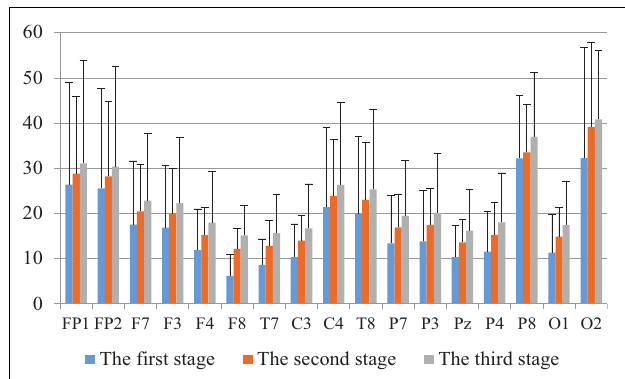
FIGURE 8 | The characteristics of theta wave power changes in whole brain regions of anxious subjects in the three experimental stages.